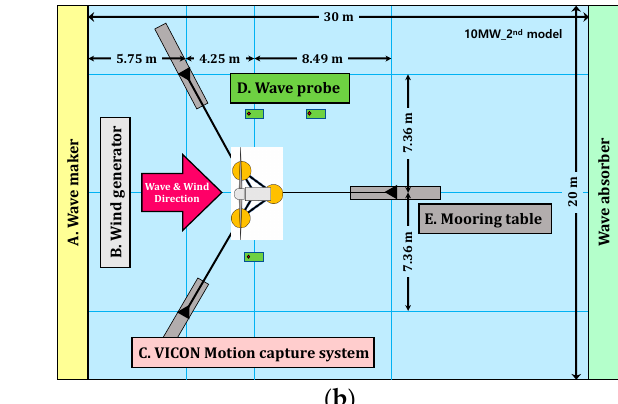
Figure 2. Installation view of test model.